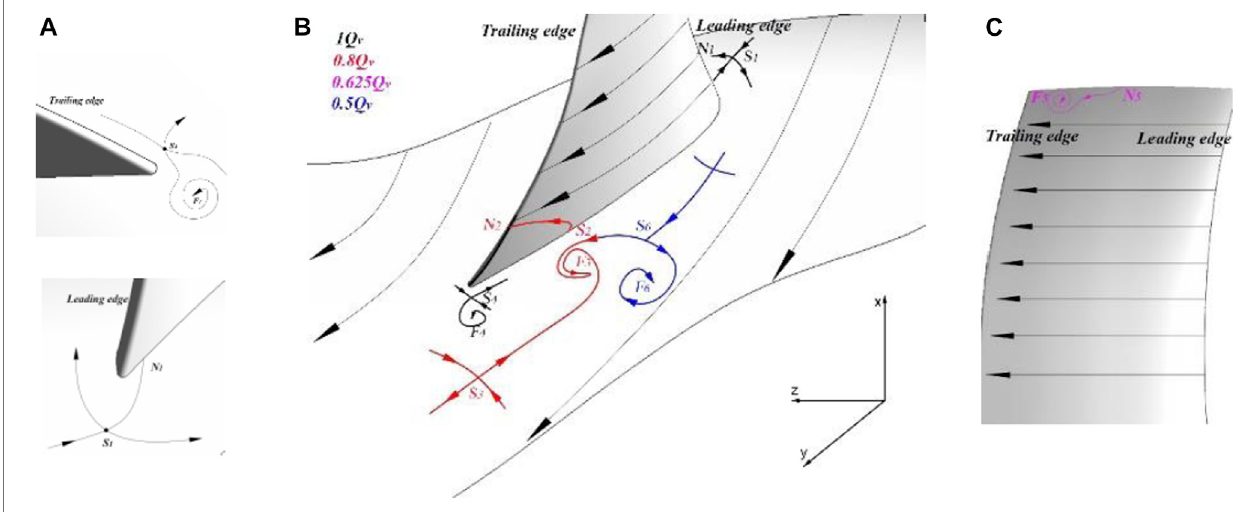
FIGURE 13 | Topology under different fl owrates.